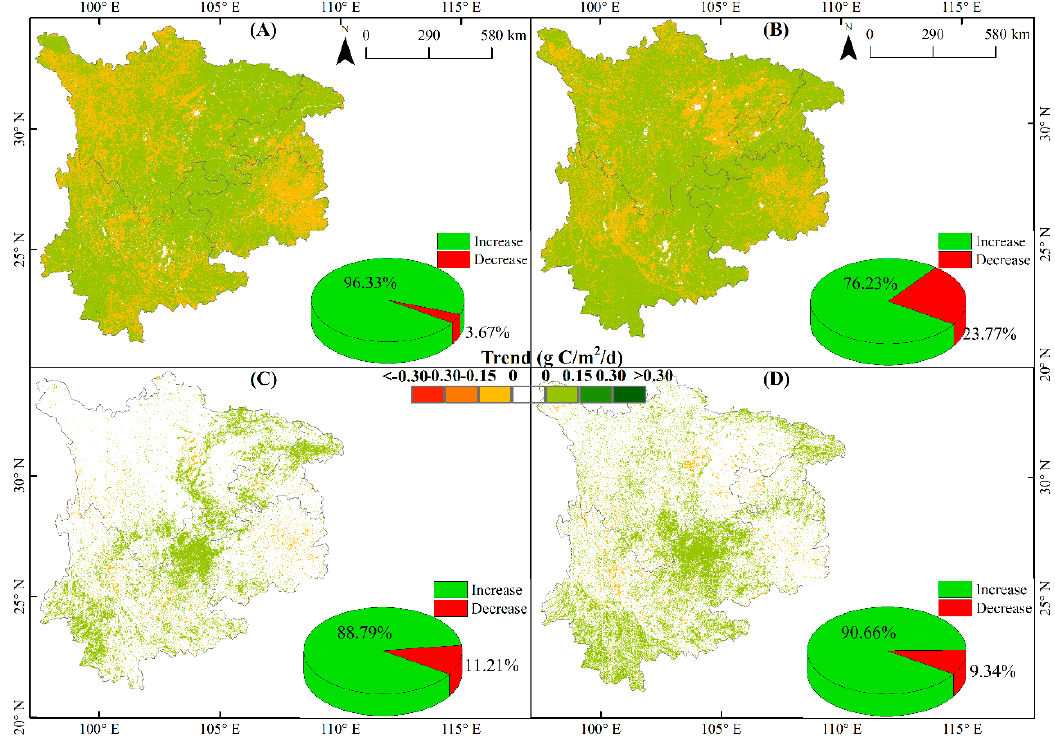
Figure 7. Complete and significant ( p < 0.05) trends for ( A , C ) MODIS and ( B , D ) BESS GPPs.